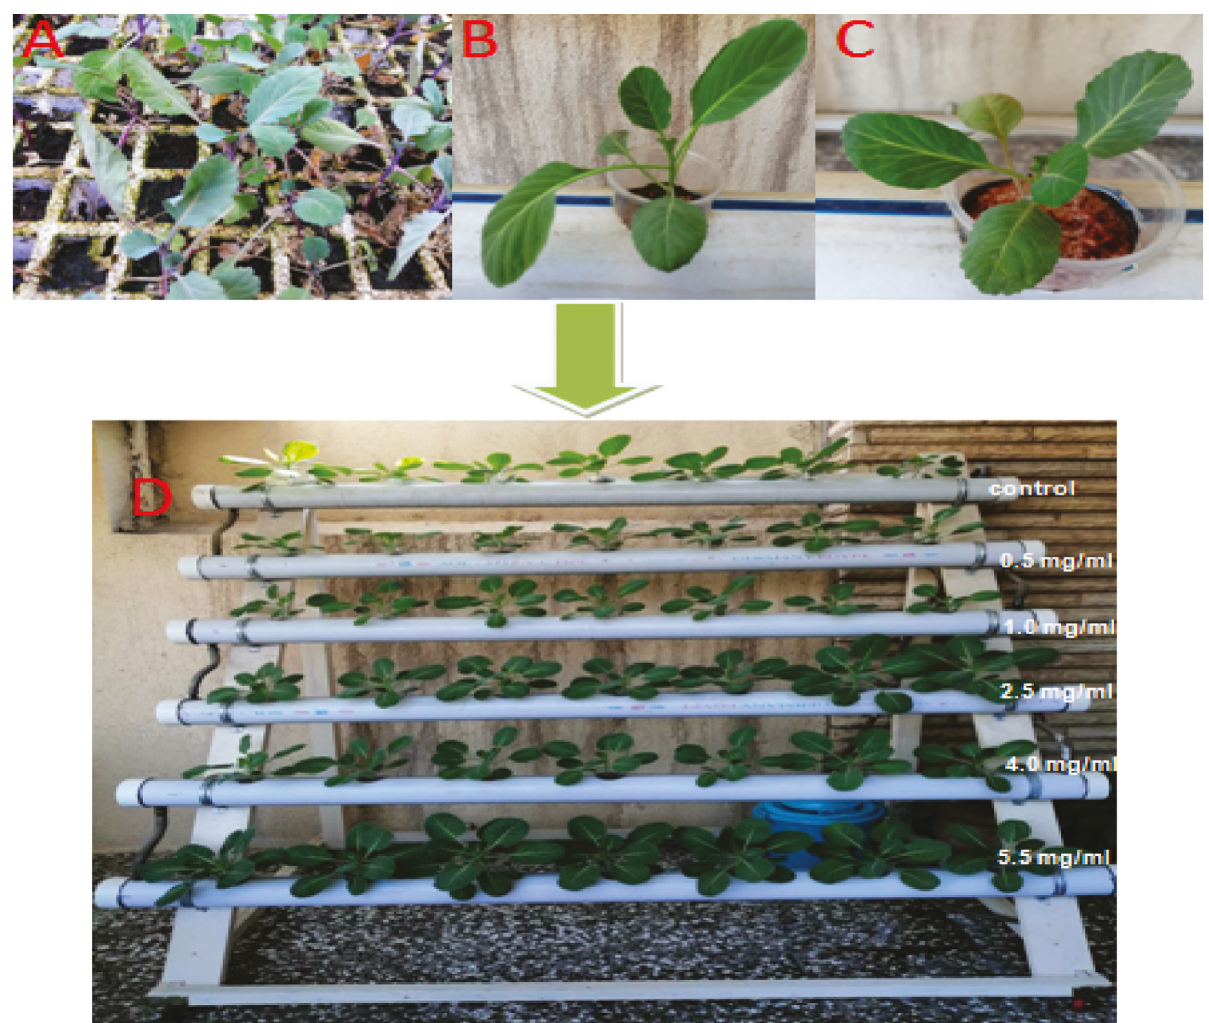
Figure 8: Cabbage crop cultures in the hydroponic system: (a) in the first week of culture; (b) in the second week of culture; (c) in the third week of culture; (d) in the fourth week of culture, n � 7. Table 4: AgNP effects on catalase or peroxidase enzymes activity, n � 7. Type of enzyme